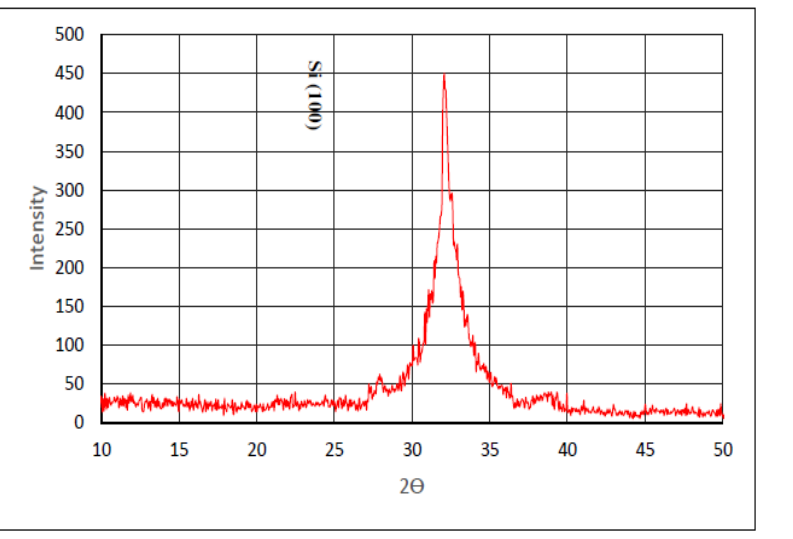
Figure 6: XRD diffraction pattern of the macPSi